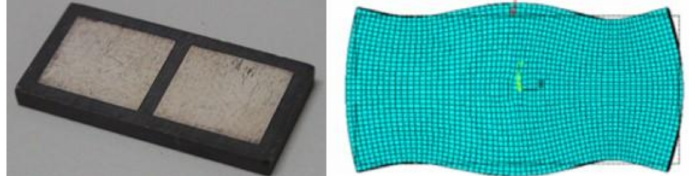
Figure 2. ( a ) The used piezoelectric material and ( b ) deformation simulation of the used piezoelectric